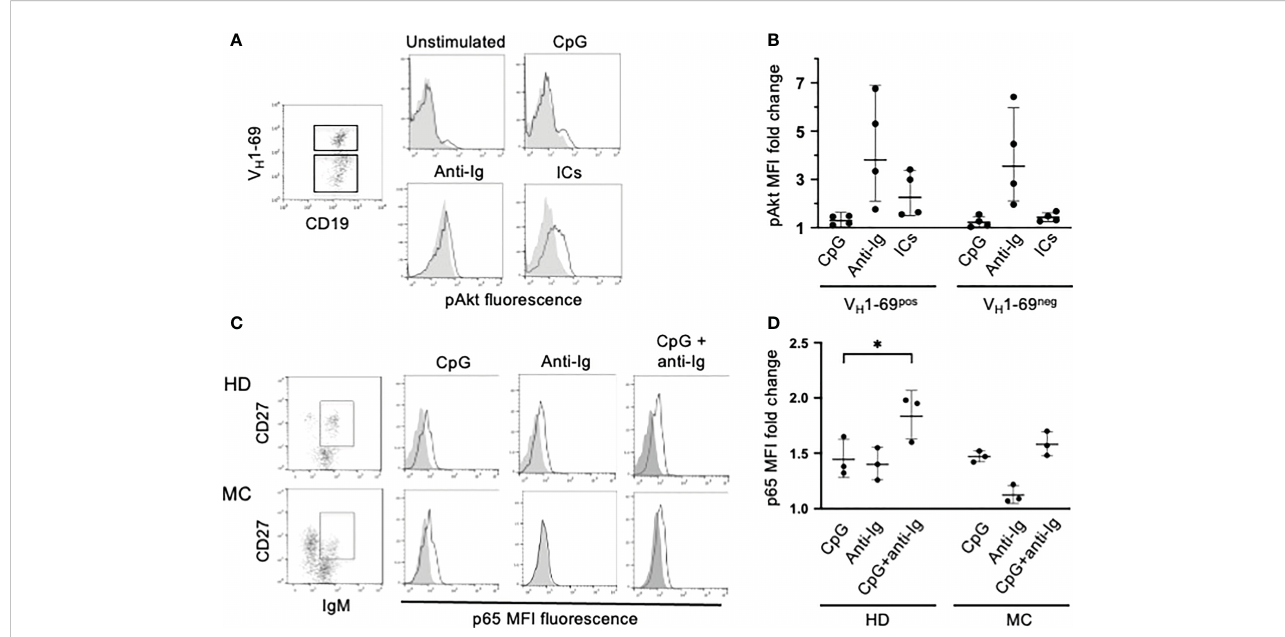
FIGURE 4 PI3K/Akt and NF-kB/p65 signaling in clonal B cells of MC patients. (A) PBMC from a representative MC patient were activated with different stimuli; electronically gated IgM + B cells were further gated into V H 1-69 pos and V H 1-69 neg cell subpopulations and analyzed for pAkt-speci fi c fl uorescence (gray histograms denote V H 1-69 neg and white histograms V H 1-69 pos cells). (B) Cumulative results in 4 MC patients (results are expressed as MFI fold change compared to unstimulated cells) illustrating that ICs induce Akt phosphorylation selectively in V H 1-69 pos cells. (C) PBMC from a representative MC patient with an IgMkCD27 pos B cell clone and from a healthy donor (HD) were left unstimulated or activated with different stimuli. After stimulation IgM pos CD27 pos cells were gated analyzed for changes in p65(pS529)-speci fi c fl uorescence (gray histograms denote unstimulated cells and white histograms stimulated cells). Results indicate that p65(S529) is phosphorylated after stimulation with CpG but not with anti-Ig in MC cells, while is ef fi ciently phosphorylated after either stimuli in HD cells. (D) Cumulative results in 3 MC patients with circulating IgMkCD27 pos B cell clones and 3 in HDs, illustrating that IgM pos CD27 pos clonal B cells of MC patients ef fi ciently phosphorylate p65(S529) after stimulation with CpG but not with anti-Ig. *p=0.048 by paired t